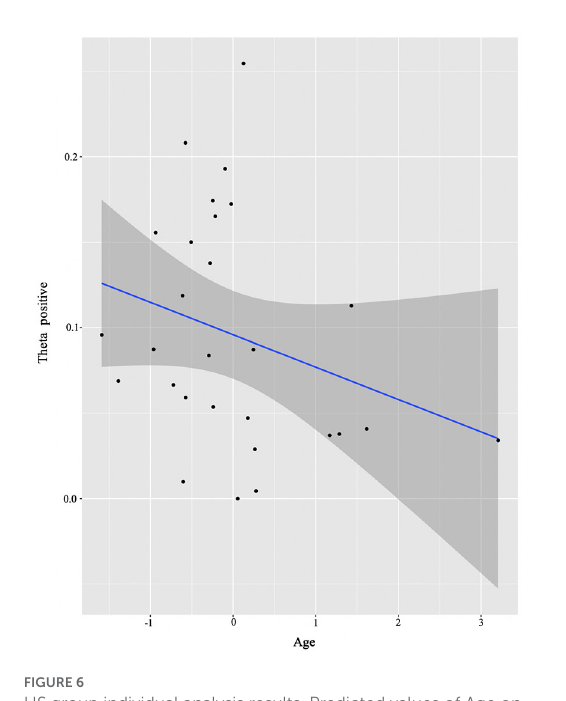
FIGURE6 HS group individual analysis results. Predicted values of Age on theta power (positive cluster) in the HS group (see Section Identifying time-frequency clusters of interest for clusters of